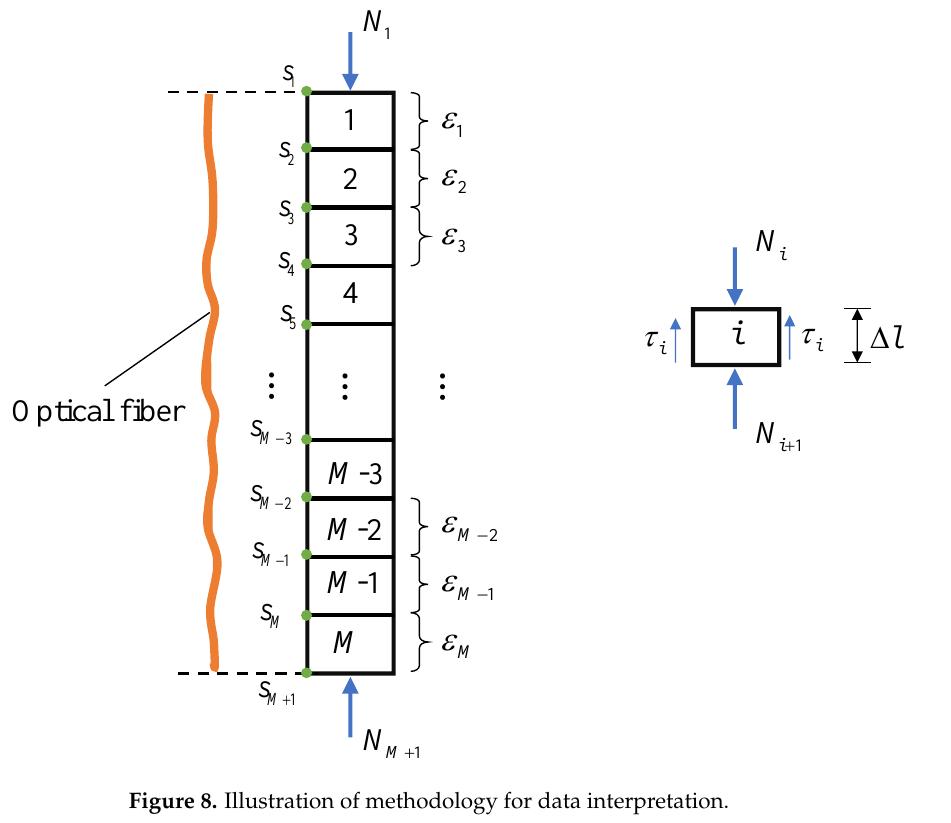
Figure 8. Illustration of methodology for data interpretation.